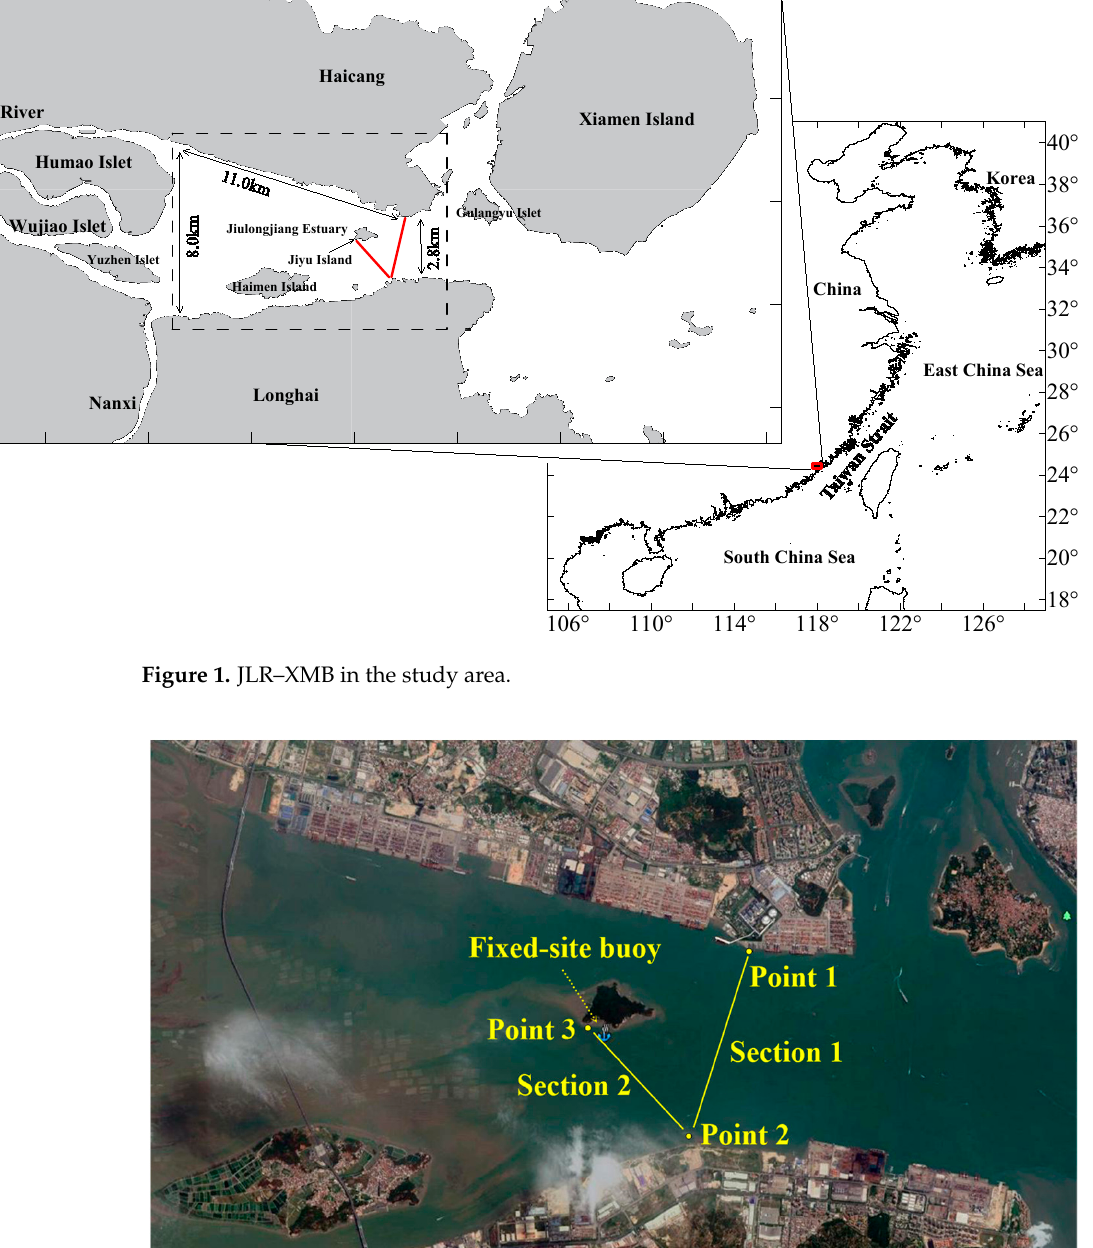
Figure 2. ADCP navigation section and fixed ‐ site station at Jiulongjiang Estuary.